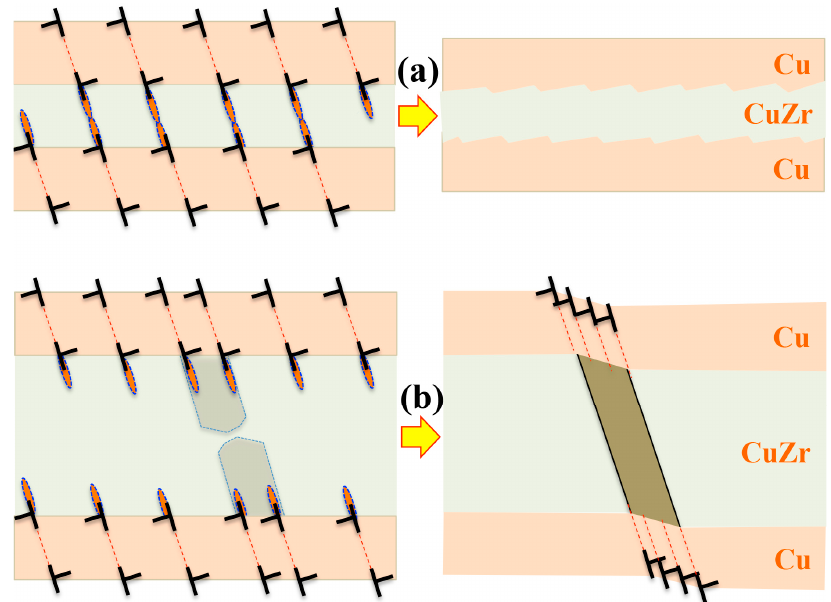
Figure 9. Schematics of plastic deformation modes with respect to the amorphous layer thickness [70]. ( a ) Plastic co-deformation in the thin amorphous layers, showing dislocation slips in the crystal Cu layers and the formation and reaction of STZs in the amorphous CuZr layers. The red ellipses represent STZs. ( b ) Shear banding in the thick CuZr layers where shear bands propagate into the Cu layers via the formation of slip bands on {111} planes.